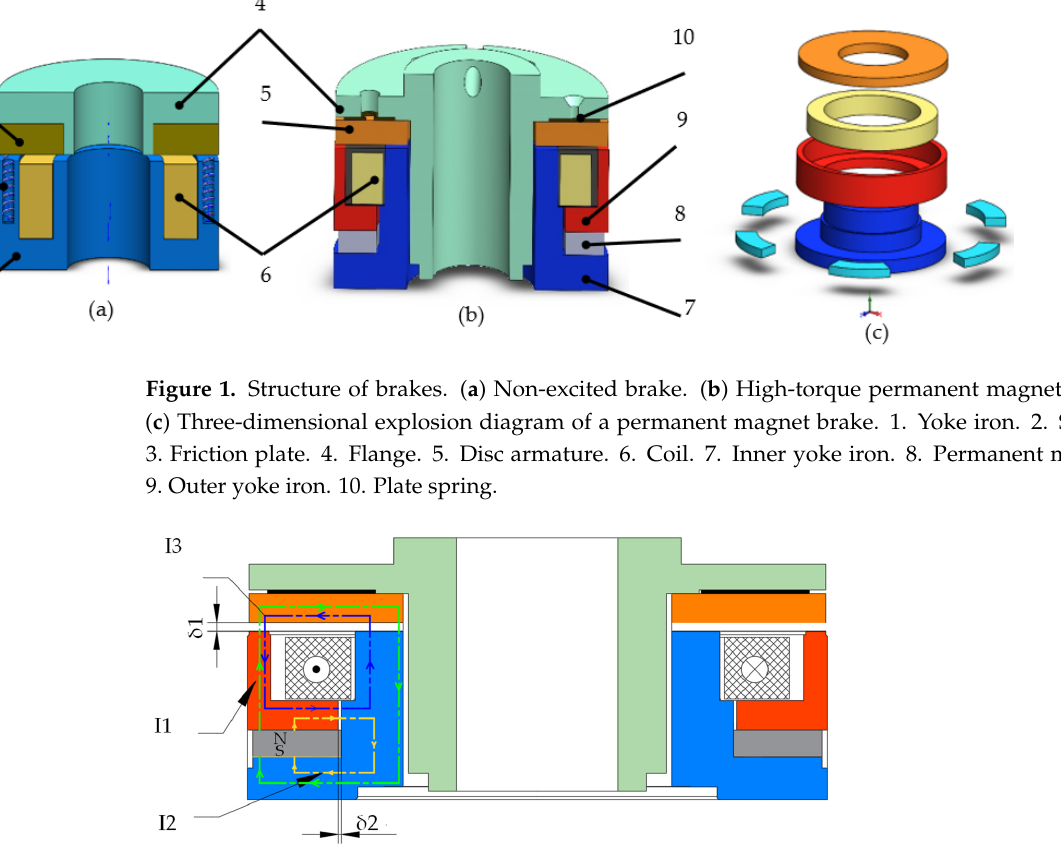
Figure 2. Magnetic cross-sectional diagram of brake in which I1 represents the magnetic circuit between the stator and the rotor generated by the permanent magnet when it is not energized. I2 represents the magnetic circuit inside the stator generated by the permanent magnet when it is not energized. I3 represents the magnetic circuit between the stator and the rotor generated by the coil when it is energized. δ 1 represents the air gap between the outer yoke and the rotor, and δ 2 represents the air gap between the stator and the